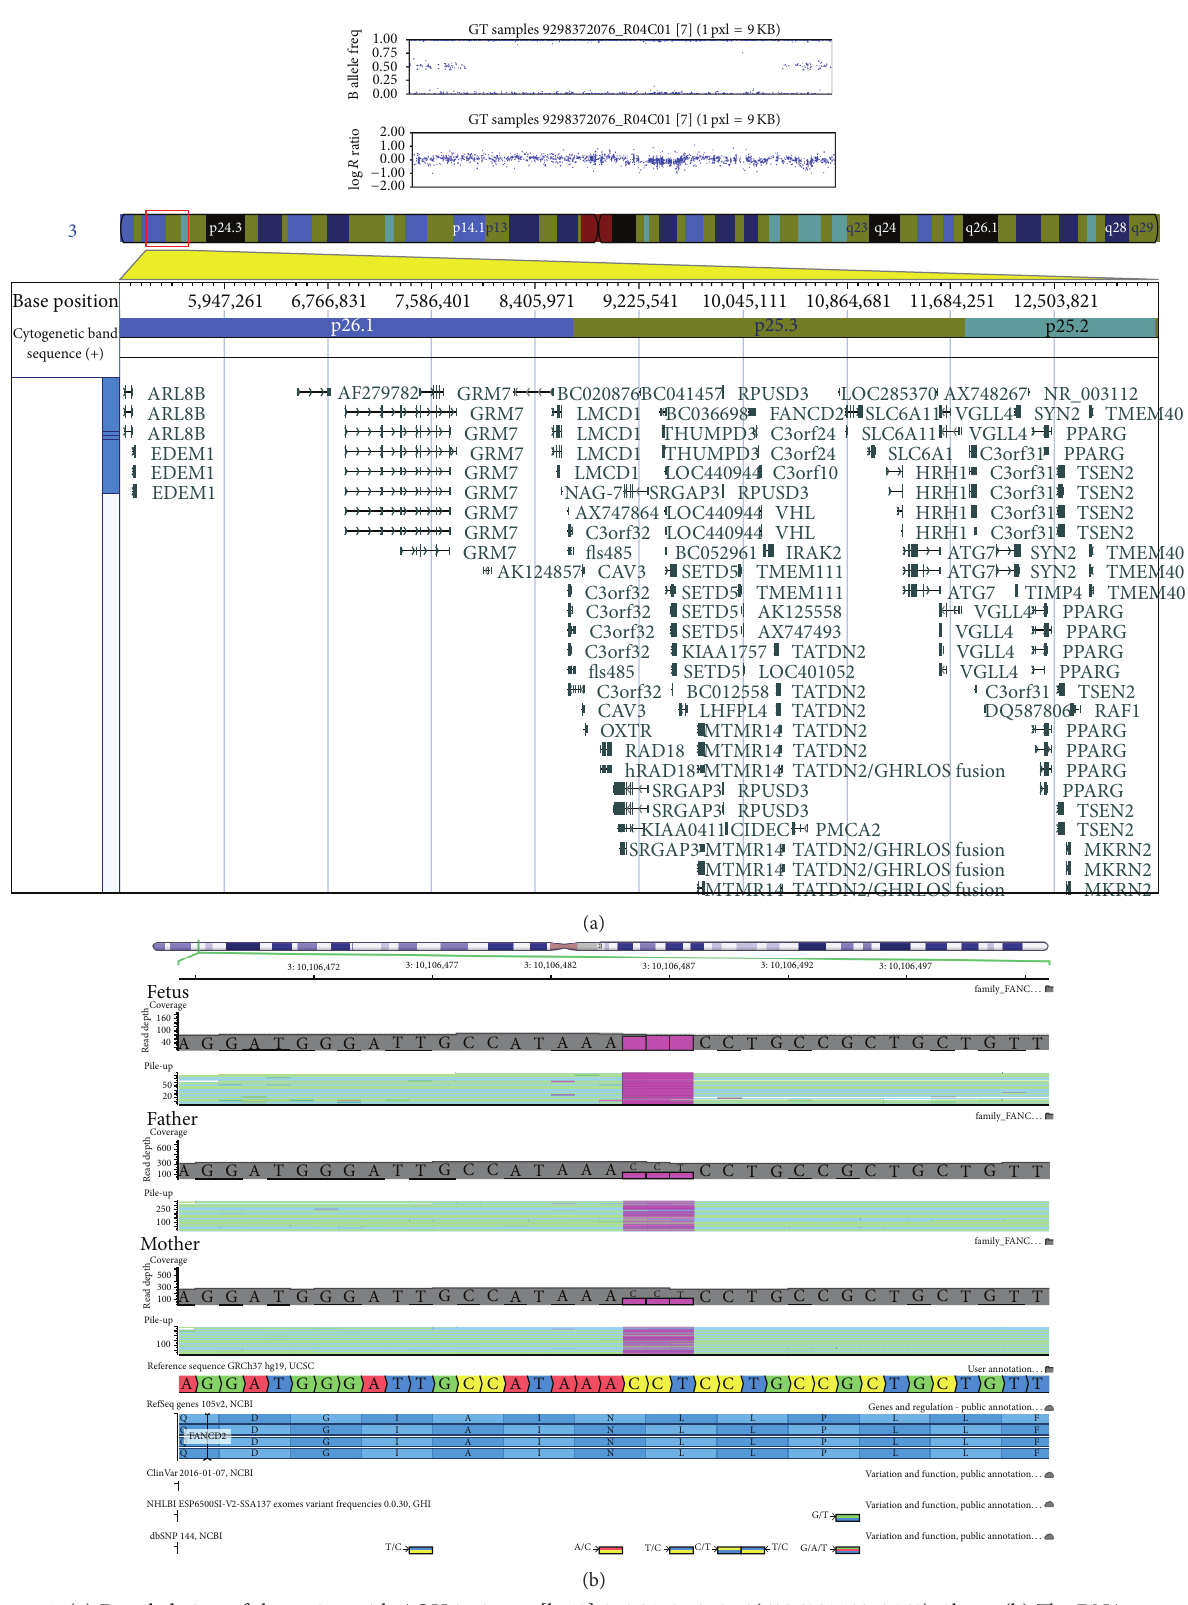
Figure 1: (a) Detailed view of the region with AOH in 3p: arr[hg19] 3p26.1p25.3p25.2(6206901-12352468)x2hmz. (b) The DNA sequences for exon 23 of the FANCD2 gene of the fetus and both parents, visualized with Golden Helix GenomeBrowse 2.0.2 software. The deletion is marked in purple. The DNA sequences of the fetus and parents are shown aligned to the reference human genome sequence (GRCh37 hg19, UCSC) and corresponding amino acid sequence of the FNCD2 protein. The deletion is not reported in dbSNP 144 NCBI and NHLBI Exome Sequencing Project data